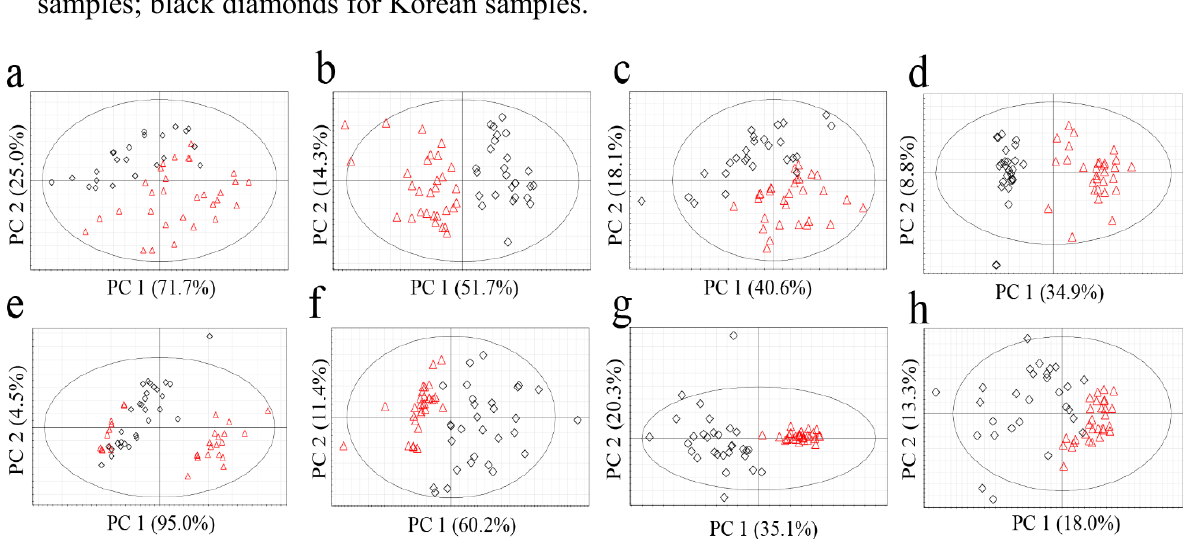
Figure 1. PCA score plots of G. elata ( a , FT-NIR; b , 1 H-NMR; c , GC-MS; d , LC-MS) and R. glutinosa ( e , FT-NIR; f , 1 H-NMR; g , GC-MS; h , LC-MS). Red triangles for Chinese